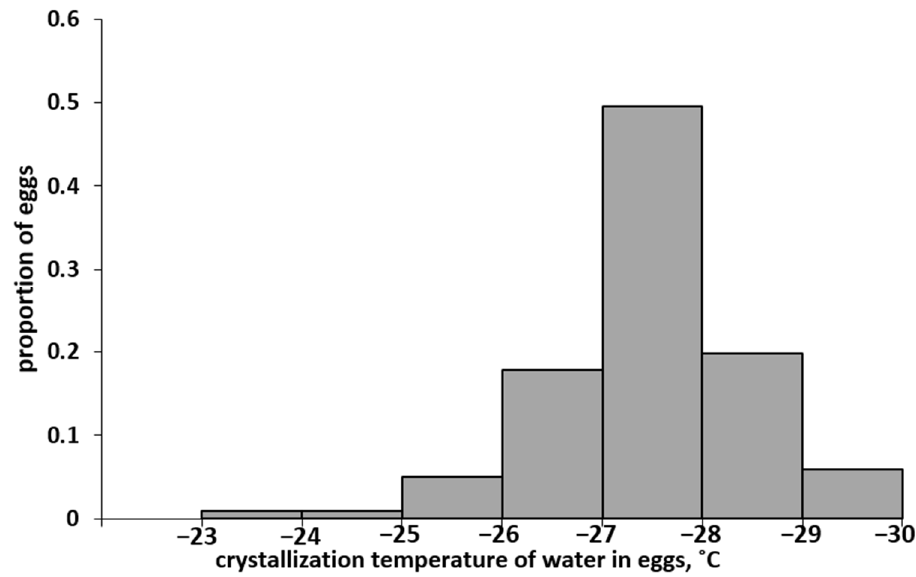
Figure 2. Distribution spectrum of eggs of the Altai SM population according to the supercooling points (SCP).